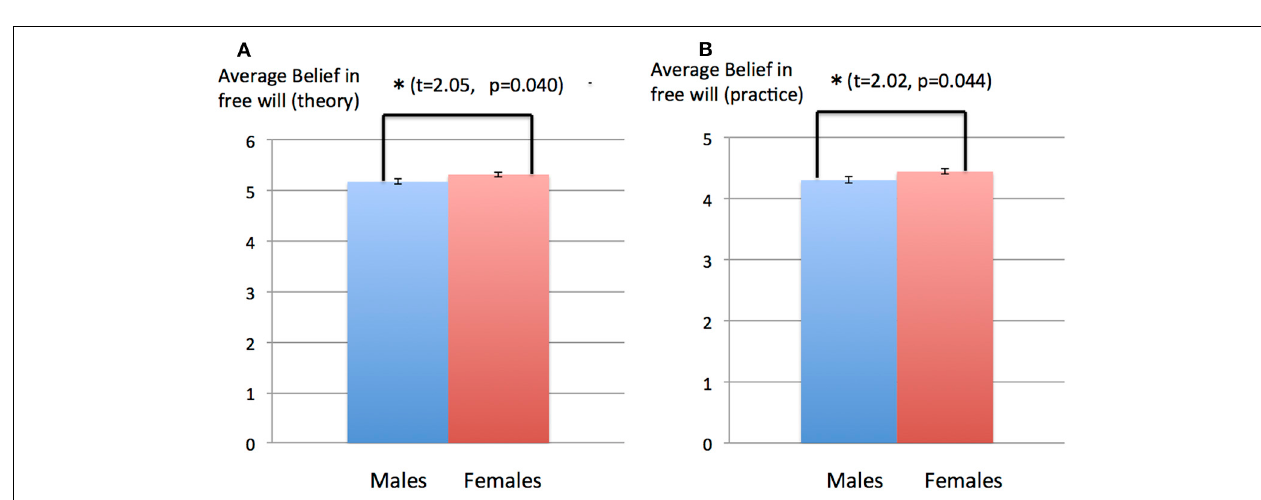
( t = 22 . 2, p = 5 . 03 × 10 − 54 ). (B) Paranormal knowledge scores for male and female subjects. The average paranormal knowledge scores for males and females were 6.49 and 6.23, respectively, with standard deviations of 6.62 and 6.66, respectively. Vertical bars represent standard errors of the mean. The difference of paranormal knowledge scores between the male and female subjects was not significant ( t = 0 . 894, p = 0 . 371).